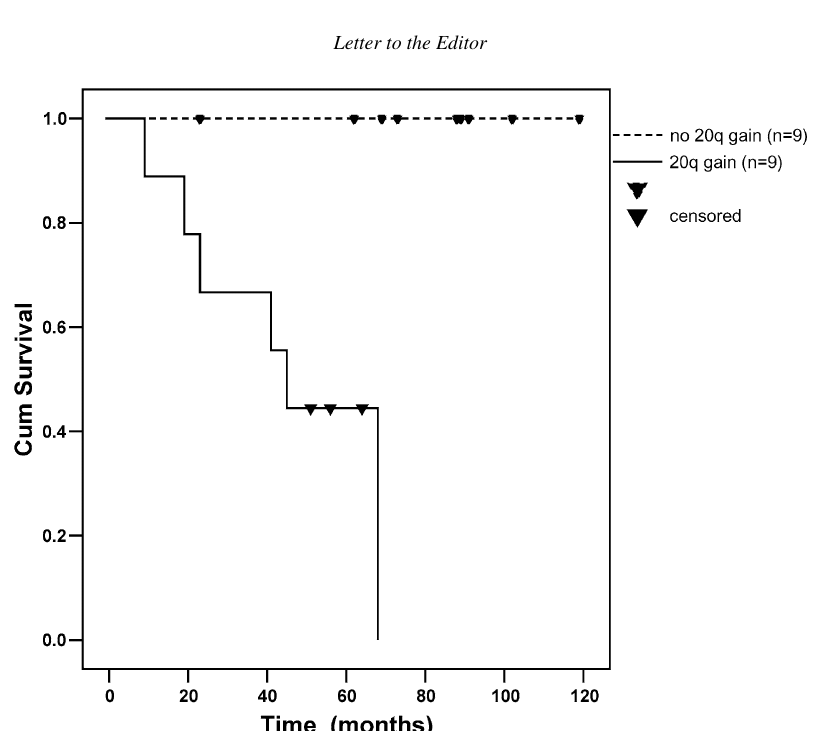
Fig. 1. Cancer related survival in 18 colorectal cancer patients with and without gain of chromosome 20q detected by CGH. Patients with 20q gain positive colorectal cancer have a significantly worse outcome. Correlations between 20q gain and histological grade, stage, tumor size, and localization in the large intestine, respectively Grade TNM stage Well Mod. Poor Total no. Total